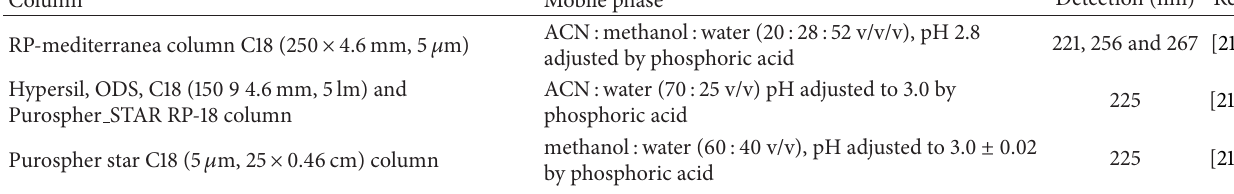
Table 4: Application of HPLC to the simultaneous determination of H